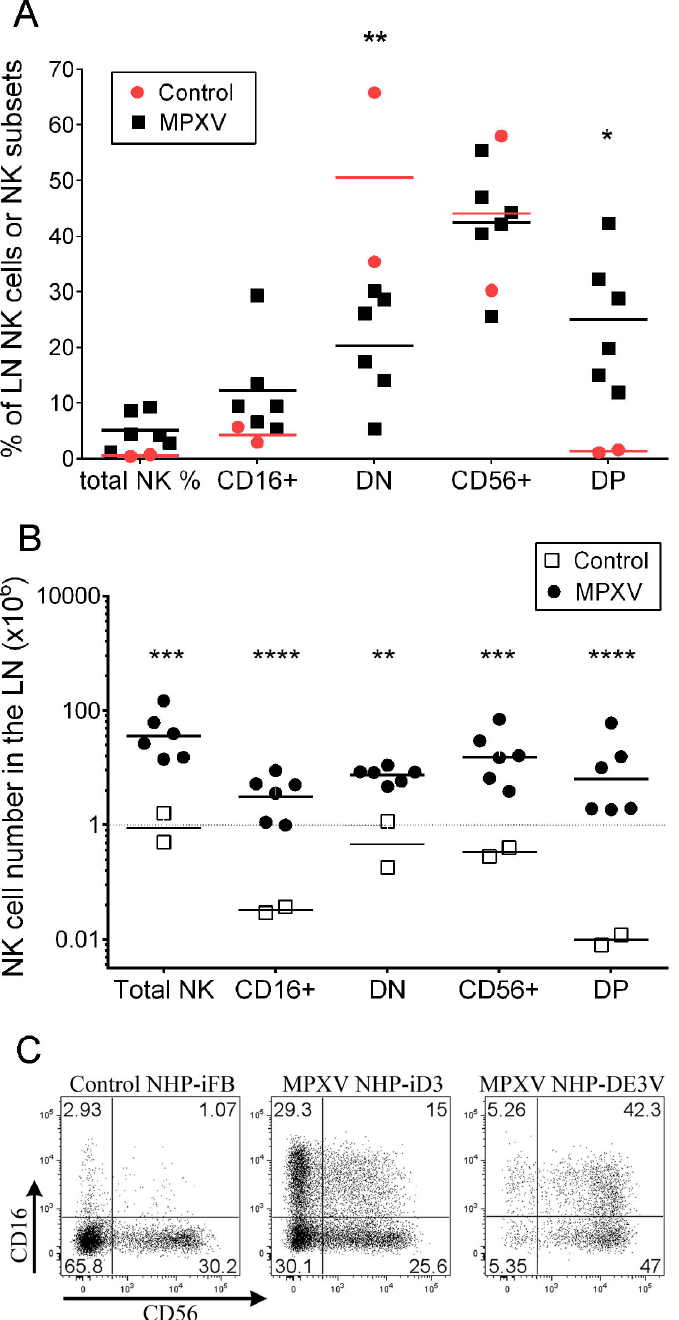
Figure 2. NK cell frequency and absolute number in LNs at days 8–9 after MPXV inoculation. A) Frequency of total NK cells in the LN lymphocyte gate and frequency of NK subsets in the NK cell gate. B) Total NK cell number and numbers of NK subsets in the LN. Total NK cell number was calculated based on the frequency of NKG2A+ NK cells in the lymphocyte gate and the total live cell number of individual LNs. The total number of NK cell subsets was calculated based on the frequency of each subset within the NK cell gate and the total NK cell number in the LN. C) Dot-plot showing the marked variation of NK cell subset distribution in two representative subjects induced by MPXV infection. Statistical analyses of A) and B) were computed using two-way ANOVA in Graph-pad Prism software with Bonferroni post-tests and p values with significant change are shown (* p<0.05, **p<0.01, *** p<0.001, **** p<0.0001). Results were confirmed using bootstrap re-sampling test computed with the R project for statistical computing. doi: 10.1371/journal.pone.0077804.g002 PLOS ONE |